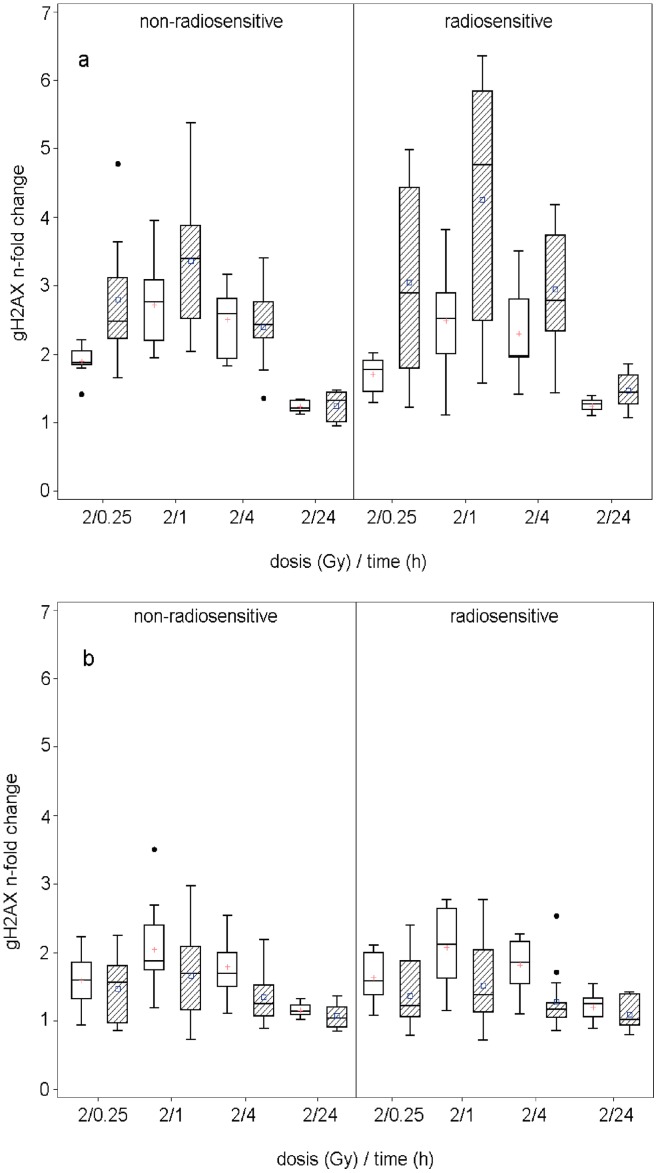
Dose-response relationship of Gamma-H2AX at different time points from two different centres (white boxes – centre C, hatched boxes – centre B).Each measured value corresponds to the n-fold change to the time point at 0 Gy after 24 hours. (a) Data for the PBLs: Box plots only include samples with an initial cell viability of higher than 80%. (b) Data for LCLs over all samples.